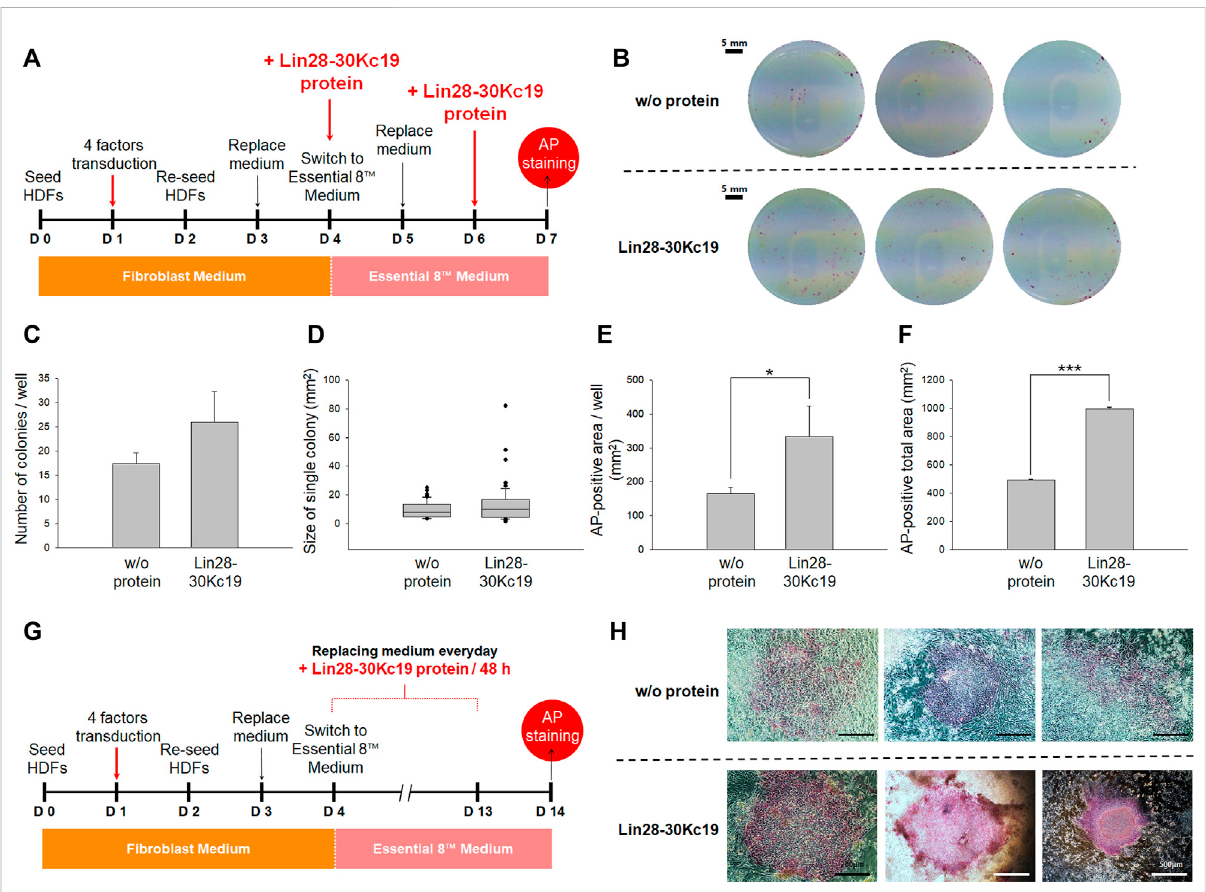
FIGURE 6 Characterization of hiPSCs generated by the addition of the Lin28-30Kc19 protein. (A) Timeline for characterization of hiPSCs at an early stage (day 7). (B) Naked eye images to detect reprogramming ef fi ciency on day 7. HDFs treated with the Lin28-30Kc19 protein on days 4 and 6 were analyzed byAP staining. Scalebars indicate 5 mm. (C) Number ofAP-stained colonies inawell on day7. The AP-positive colonies werecounted and compared in the without and with protein groups. (D) Size of an AP-positive single colony on day 7. Each AP-stained area was quanti fi ed and compared in the without and with Lin28-30Kc19 protein groups. (E) The AP-positive area in a well on day 7. Positively detected area was measured and comparedwithout and with the recombinant protein groups. (F) The total area positively stained with AP in three wells on day 7. The area of AP- positive colonies was summed up and compared in without and with the protein groups. * p < 0.05 and *** p < 0.001. n = 3. (G) Timeline for the characterization of hiPSCs after passaging (day 14). (H) Microscopic images to con fi rm reprogramming ef fi ciency on day 14. HDFs treated with the Lin28-30Kc19 protein on days 4, 6, 8, 10, and 12 were analyzed by AP staining. Scale bars indicate 500 μ